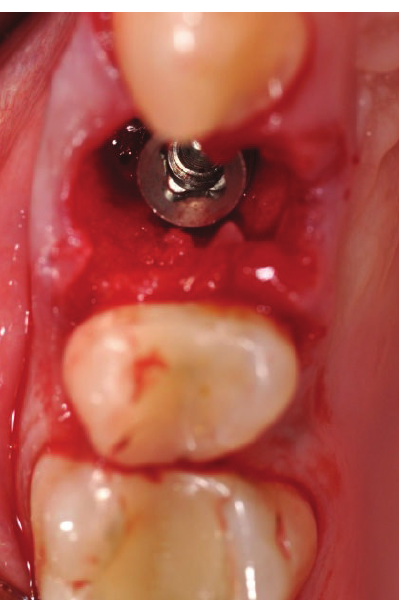
Figure 6: Early placement of the implant.